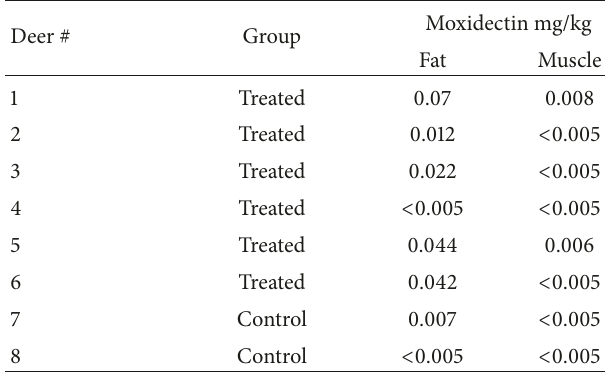
Table 4: Results from laboratory analysis of tissues taken from six rising one-year-old mixed sex red deer dosed per os with a 50/50 mixture of Exodus Pour-On and Oxfen C Plus at a minimum of 1ml/5 kg 39 days prior to slaughter and two rising one-year-old red deer that were